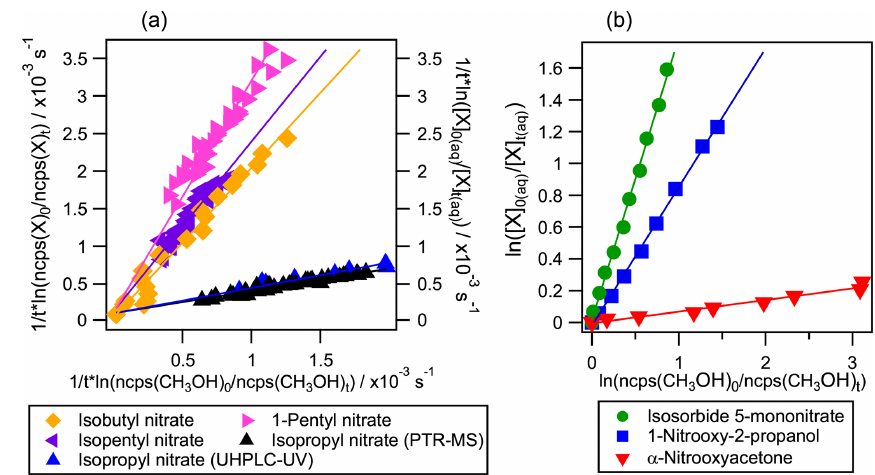
Figure 4. Examples of competition kinetic results for the studied organic nitrates using the new developed method: experiments 8, 14, 16, 19, 21, 24, and 26 (listed in Table S2). In panel (a) molecules were monitored in the reactor’s headspace by PTR-MS (left axis and horizontal axis) except for isopropyl nitrate which was also monitored by UHPLC-UV (right axis). In panel (b) methanol was monitored in the reactor’s headspace by PTR-MS (horizontal axis) while the polyfunctional organic nitrates were followed by UHPLC-UV (left axis). (cid:113) Table 2. Aqueous-phase OH-oxidation rate constants for eight organic nitrates: comparison between the experimental rate constants ( k OHexp ) and the simulated ones ( k OHsim ) using the extended SAR. Calculations use the SAR parameters indicated in Table 4. The fac- tor (cid:49) is the relative difference between the simulated and the experimental rate constant (Eq. 10). n stands for the number of experimental determinations of each rate constant (note that for isopropyl nitrate six experiments were performed; in three of them the value was deter- mined twice using both Eqs. (4) and (5), thus resulting in nine determinations). Experimental uncertainties are 95% confidence interval. Studied compounds k OHexp ( × 10 8 Lmol − 1 s − 1